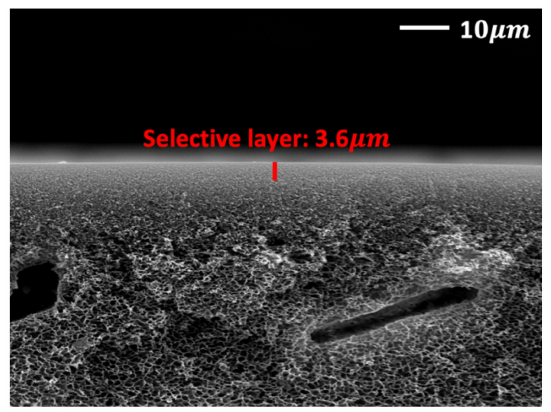
Figure 1. SEM image: PVP/CuO/ p -BQ composite membrane coated onto polysulfone